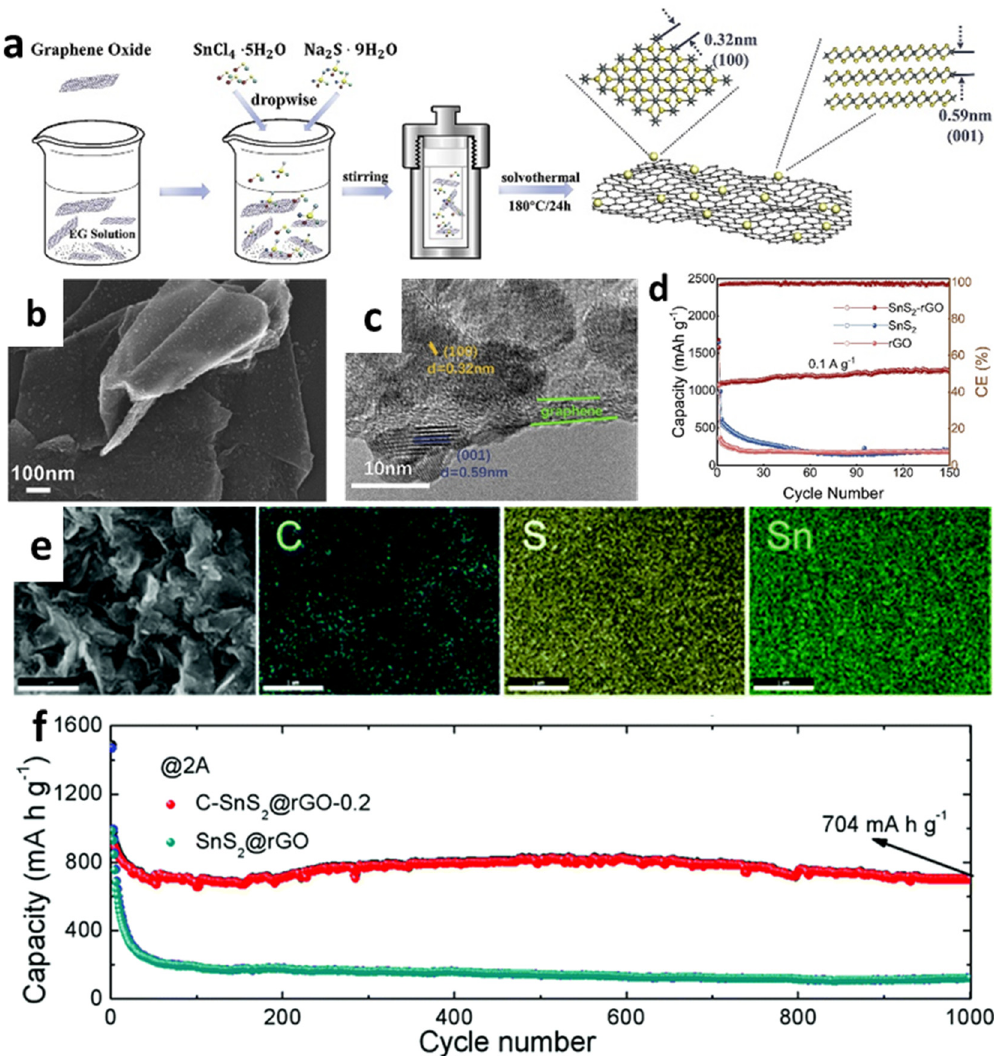
Figure 7. ( a ) Synthesis procedures diagram, ( b ) TEM and ( c ) HRTEM images, and ( d ) cycling per ‐